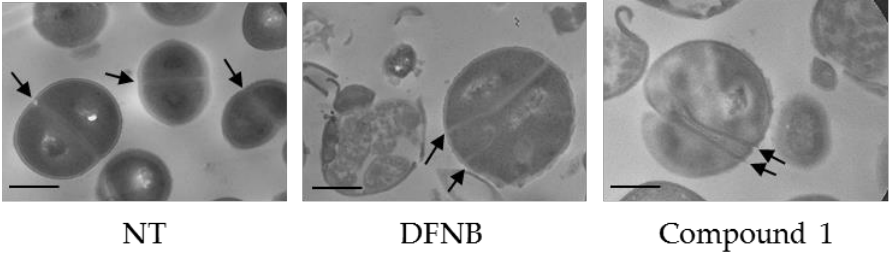
Figure 4. Ultrastructural analysis by TEM of S. aureus (MRSA) cultured overnight in the presence of 1 at 1 μg/mL. Bacteria with no compound (NT) or in the presence of DFNB (0.25 μg/mL) were used as negative and positive control, respectively. Arrows indicate the septum. Alterations in septum formation are clearly visible in the samples treated with DFNB and 1 . Scale bar: 1 μm.